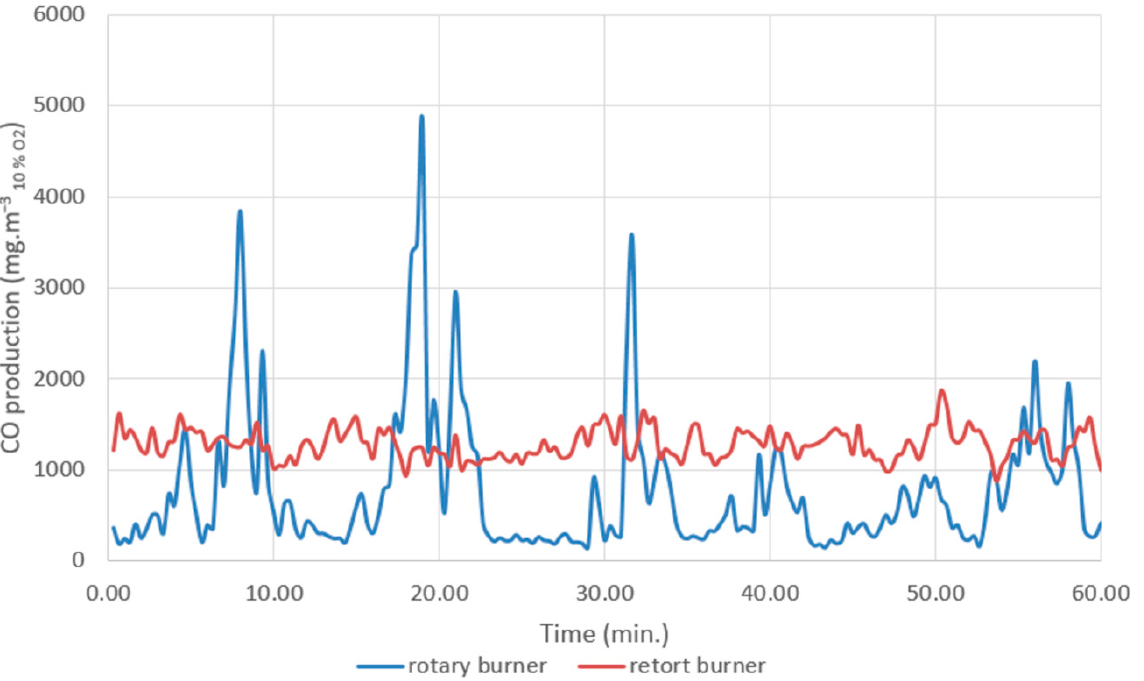
Figure 7. Typical time courses of CO emissions depending on the type of burner from experiments.